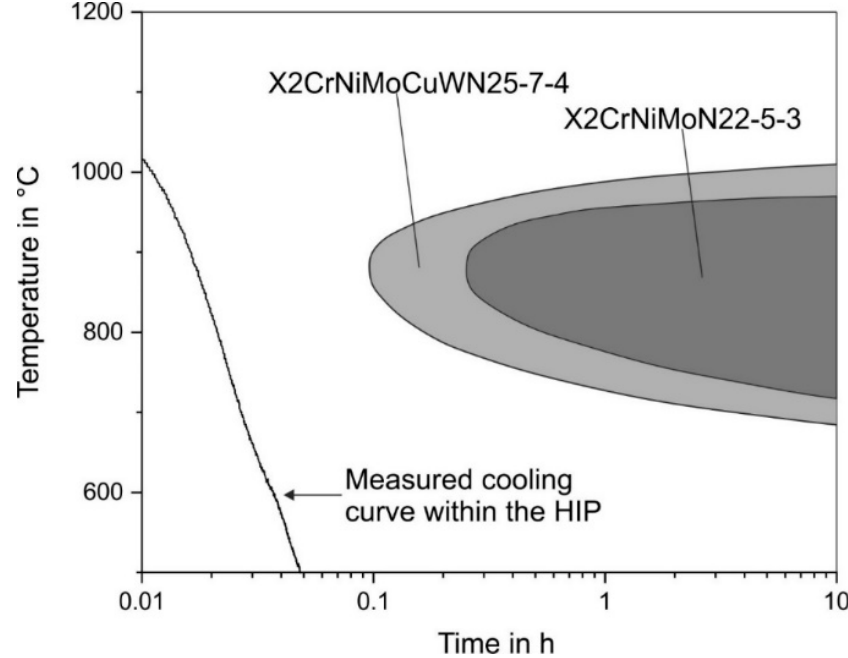
Figure 7. Isothermal time–temperature phase diagram for the sigma phase formation in the duplex steels X2CrNiMoN22-5-3 and X2CrNiMoCuWN25-7-4 [6]. The measured cooling curve within the HIP was added subsequently.